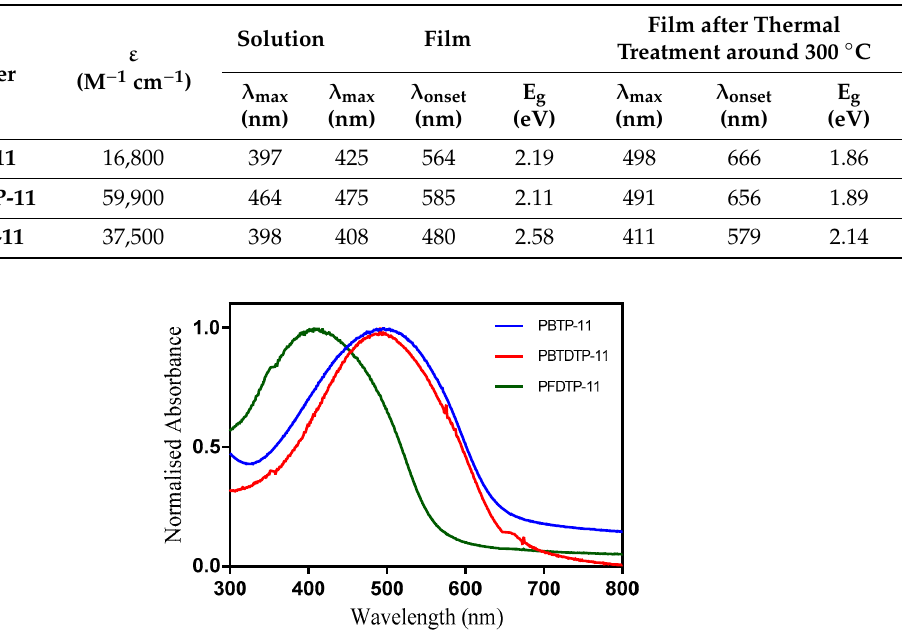
Figure 2. Normalized UV-vis absorption spectra of PBTP-11, PBTDTP-11 and PFDTP-11 after thermal treatment around 300 °C for 1 h . Table 2. Data and optical band gaps of the polymers .